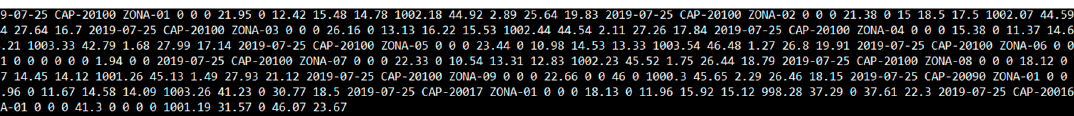
Figure 6. Formatted string.